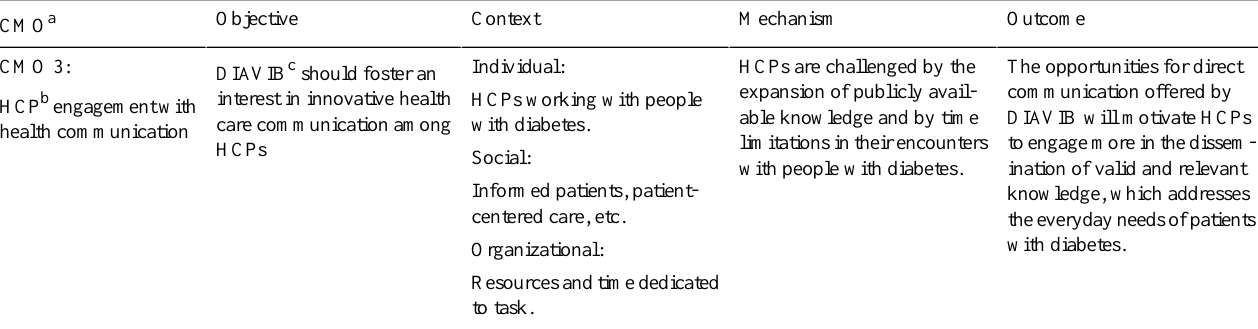
Table 4. Context-mechanism-outcome configuration 3: Diabetes Viborg supports health care professional engagement with health communication. OutcomeMechanismContextObjectiveCMO